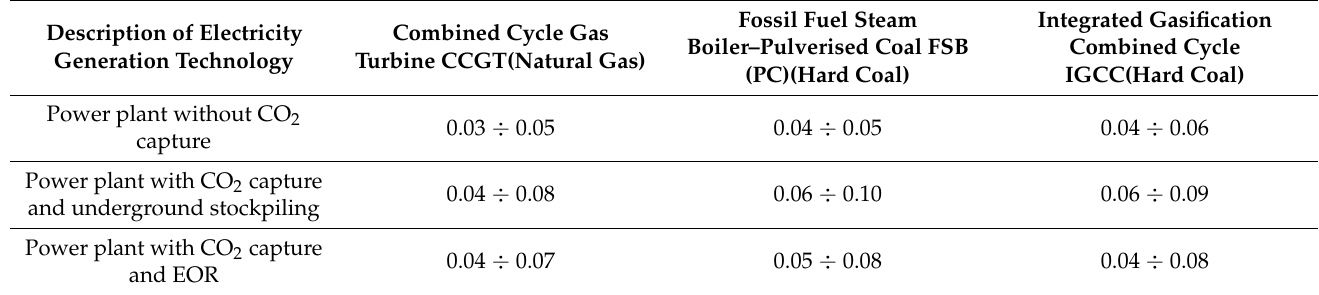
Table 2. Estimated electricity costs with and without the CCS technology (2002 USD/(kWh)). Source: [4].